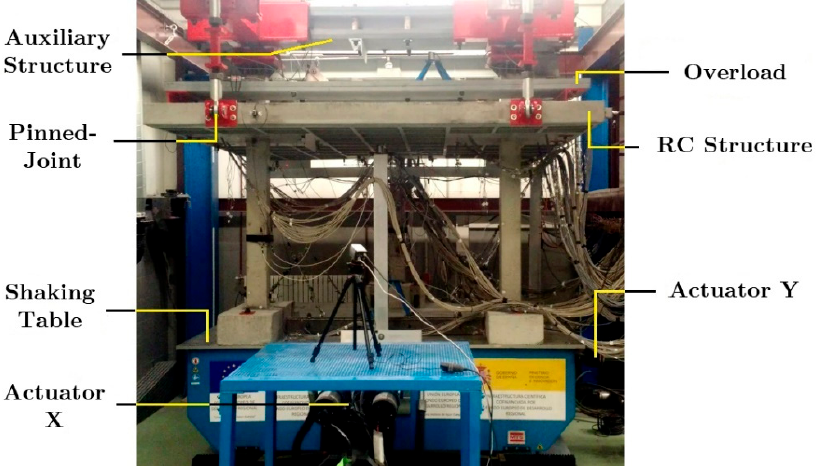
Figure 3. General setup of the seismic test: Shaking table of the Laboratory of Structures of the University of Granada (actuators X and Y), reinforced concrete (RC) main structure with overload, and auxiliary metallic structure.